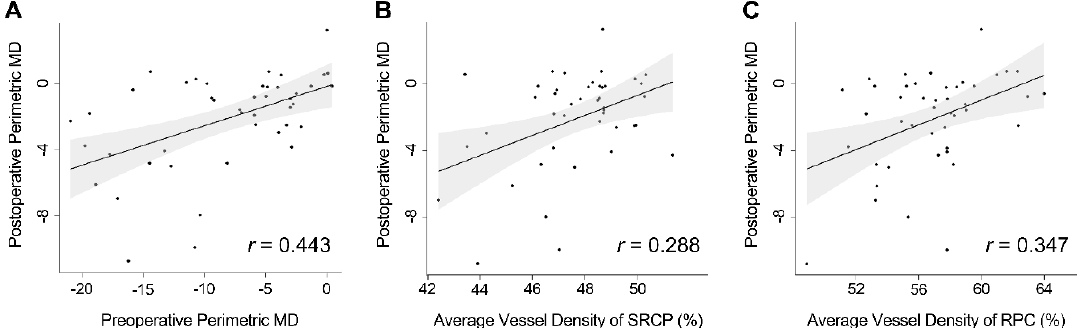
Figure 2. Scatterplots illustrate the correlation between postoperative mean deviation (MD) of visual field (VF) and preoperative MD of VF (r = 0.443, p = 0.001) (A) , vessel densities of superficial retinal capillary plexus (SRCP) (r = 0.288, p = 0.035) (B), radial peripapillary capillary (RPC) segment (r = 0.347, p = 0.009) (C) . The black line indicates the linear regression line and the dark gray area the corresponding 95% CI.